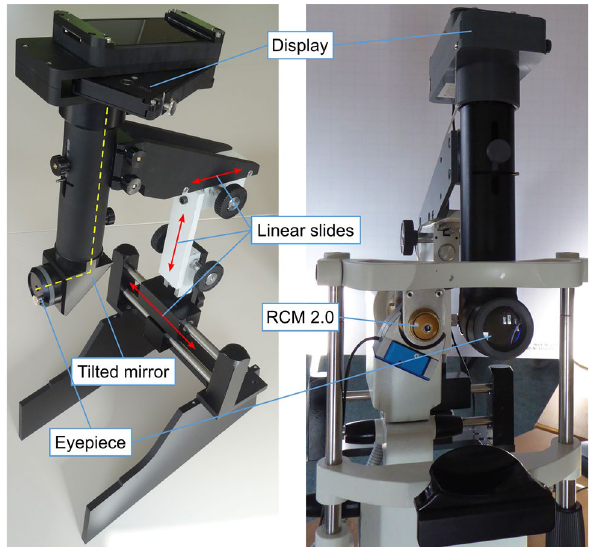
Figure 1. (Left) The EyeGuidance system. Dashed yellow line: optical axis. Red doublesided arrows: linear slides for individual positioning. (Right) The EyeGuidance system, mounted to an HRT confocal microscope. The HRT is equipped with an RCM 2.0.